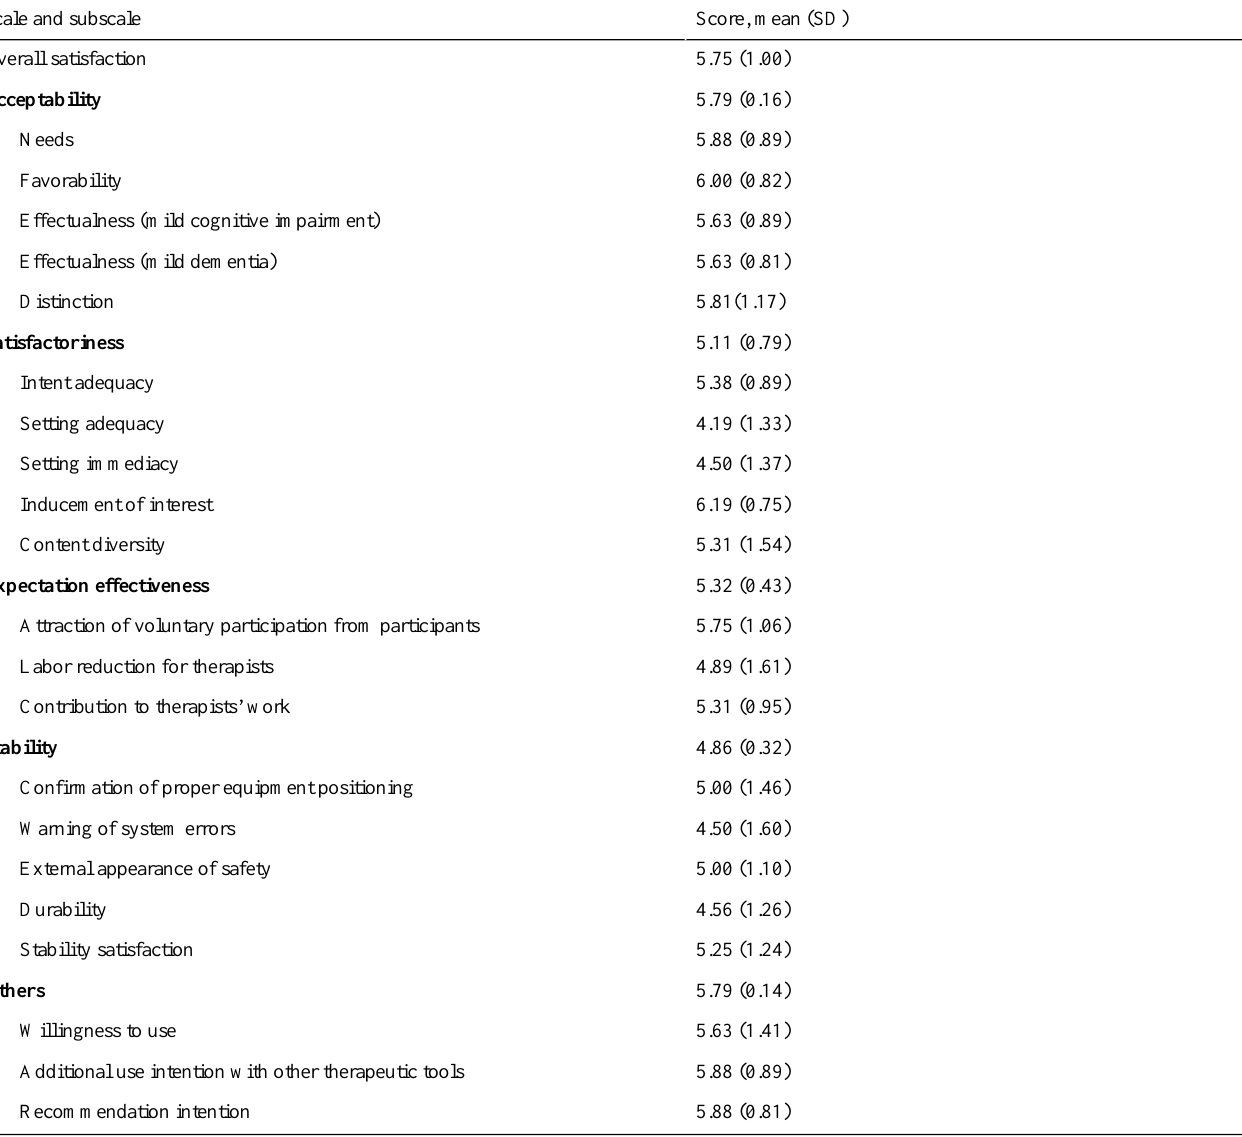
Table 1. Physiatrists’and occupational therapists’self-report questionnaire results on a 7-point Likert-type scale. The higher the score, the more positive the